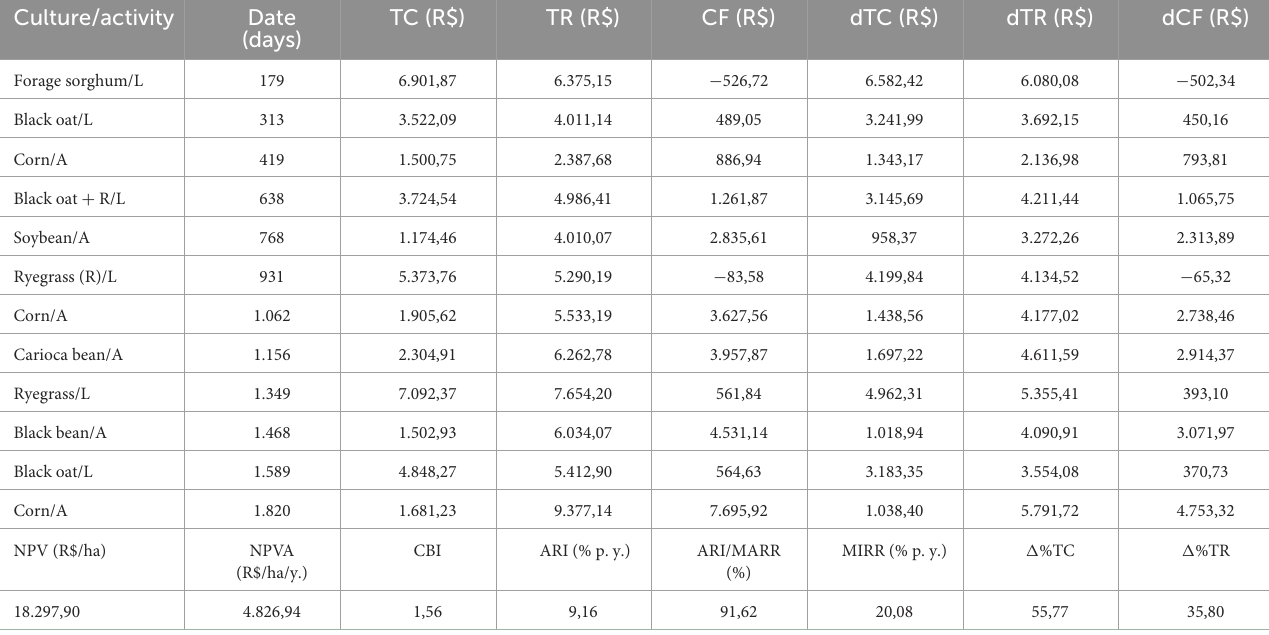
TABLE 3 Total cost (TC), total revenue (TR), cash flow (CF), and ICLS return, risk, and sensitivity indicators for 5.5 years.